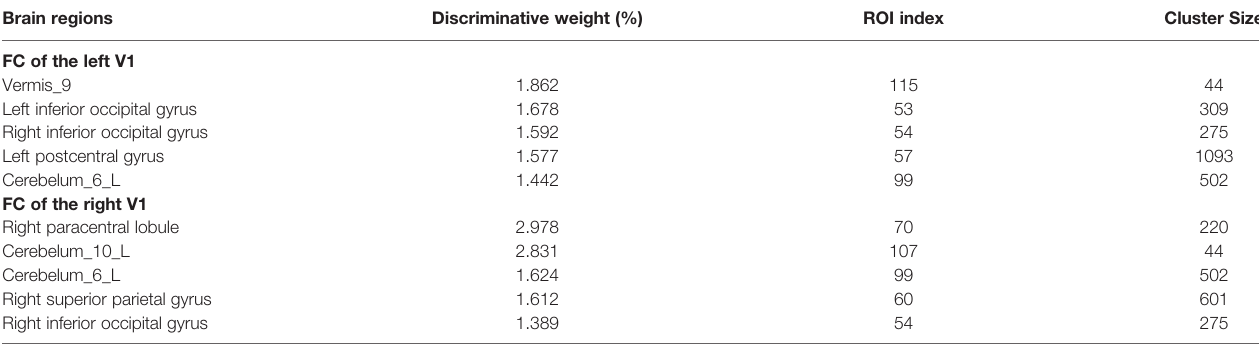
TABLE 5 | Brain areas contributed most for classi fi cation between iridocyclitis and HC groups for the FC feature. Brain